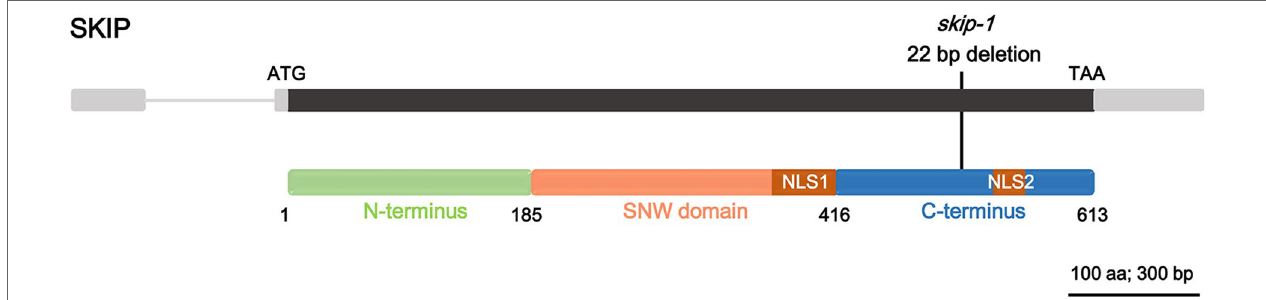
FIGURE 1 | The domain structure of ski-interacting protein (SKIP) and the location of skip-1 mutant. Gray box: UTR; gray line: intron; black box: exon; colored boxes: domain feature of the protein; black line: the mutation site of the